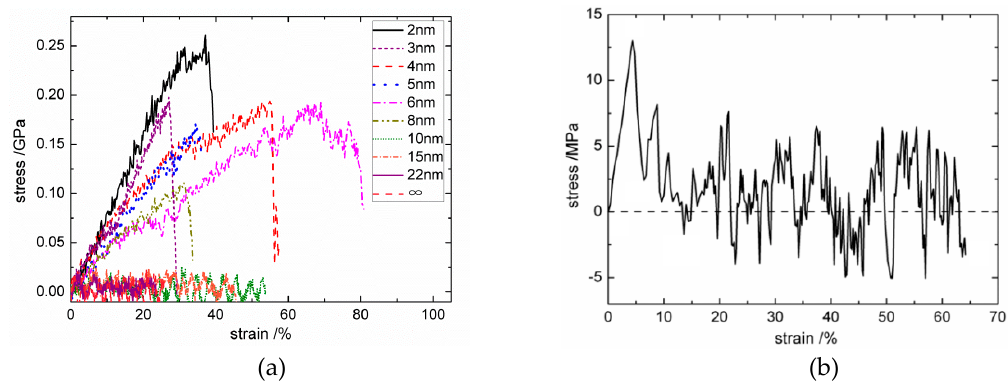
Figure 10. Typical tangential shear stress–strain curves: ( a ) the C f /PyC interphase with different sizes of L a ; ( b ) perfect hexagonal graphite.